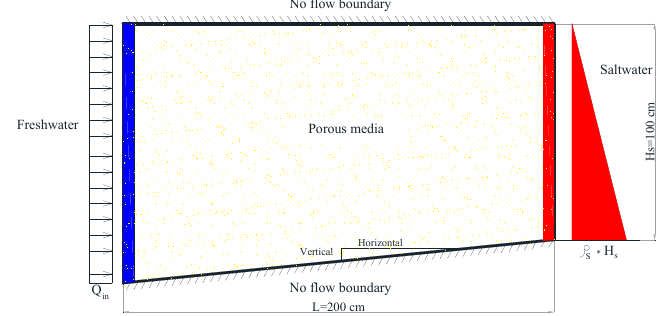
Figure 9. Schematic sketch of bed slopes of 20:1 and 10:1 toward the sea.